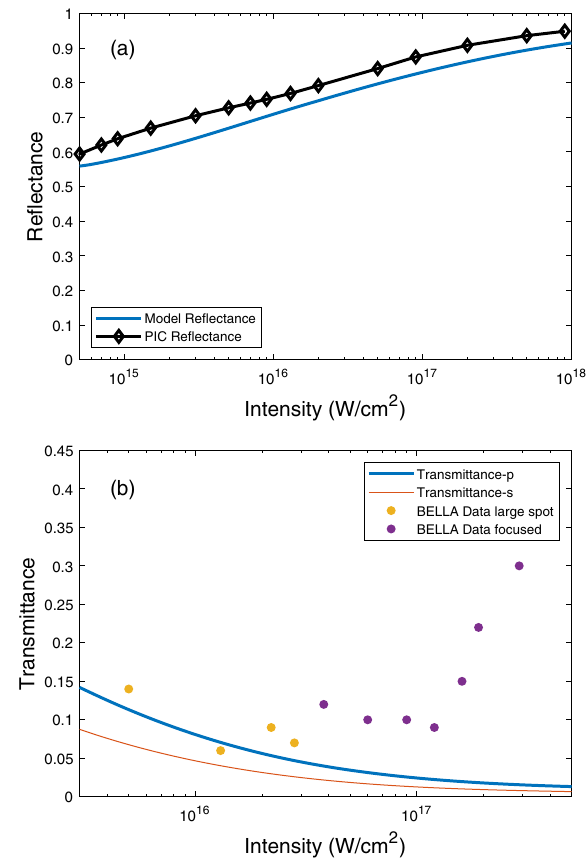
FIG. 7. (a) Reflectance vs intensity for s-polarization at 15° incidence as calculated by the model described in this article (blue) is shown in comparison to simulations from Ref. [16] (black). (b) Transmittance vs intensity for both s (solid orange curve) and p (solid blue curve) polarizations at 45° incidence again calculated with the model described here. These curves are compared to the transmission data taken in the experiment in Sec. III with a focused (purple circles) and defocused (yellow circles) beam incident on the plasma